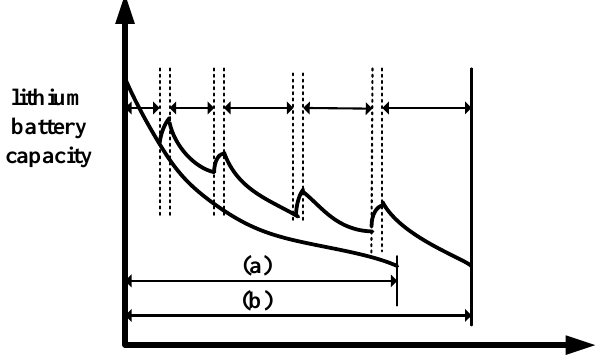
Figure 2. Lithium battery capacity changing with discharge process. ( a ) Continuous discharge; ( b ) intermittent discharge.